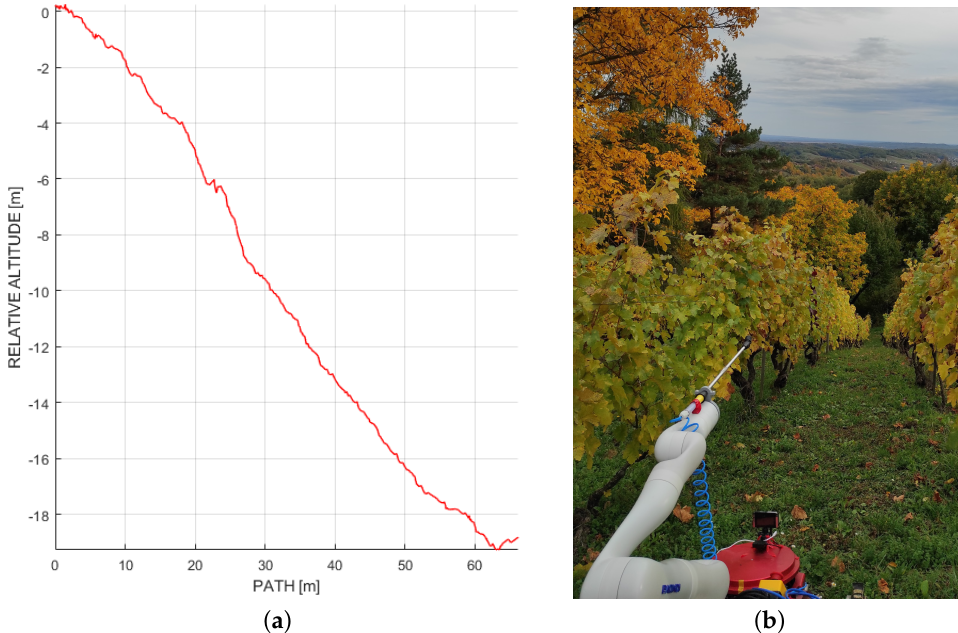
Figure 5. An example of a steep slope vineyard used for previous work and described in [13]. One can see the influence of the slope on the field of view of the robot. The vineyard shown has a slope of up to 54%. ( a ) A cross-section of the vineyard. ( b ) An image of ATMM-VIV at the beginning of the